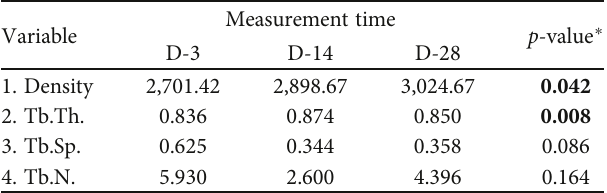
T ABLE 2: Comparison of examination results using periapical